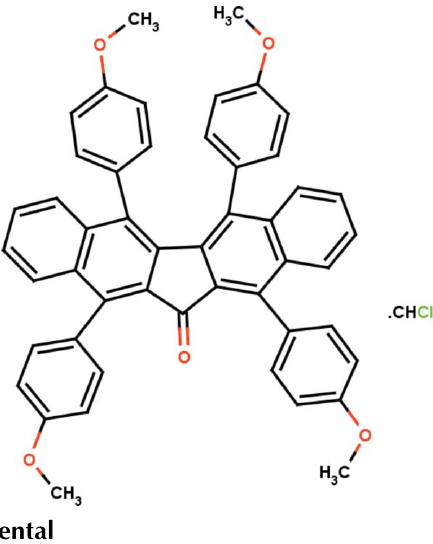
Data collection Bruker Kappa APEXII CCD diffractometer